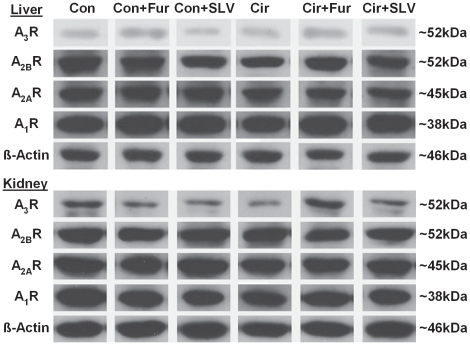
Representative immunoblots for hepatic and renal adenosine A1, A2A, A2B and A3 receptors.Beta-actin was used for normalization before statistical analysis. Con, control; Cir, liver cirrhosis; Fur, furosemide; SLV, SLV329; kDa, kilodalton.